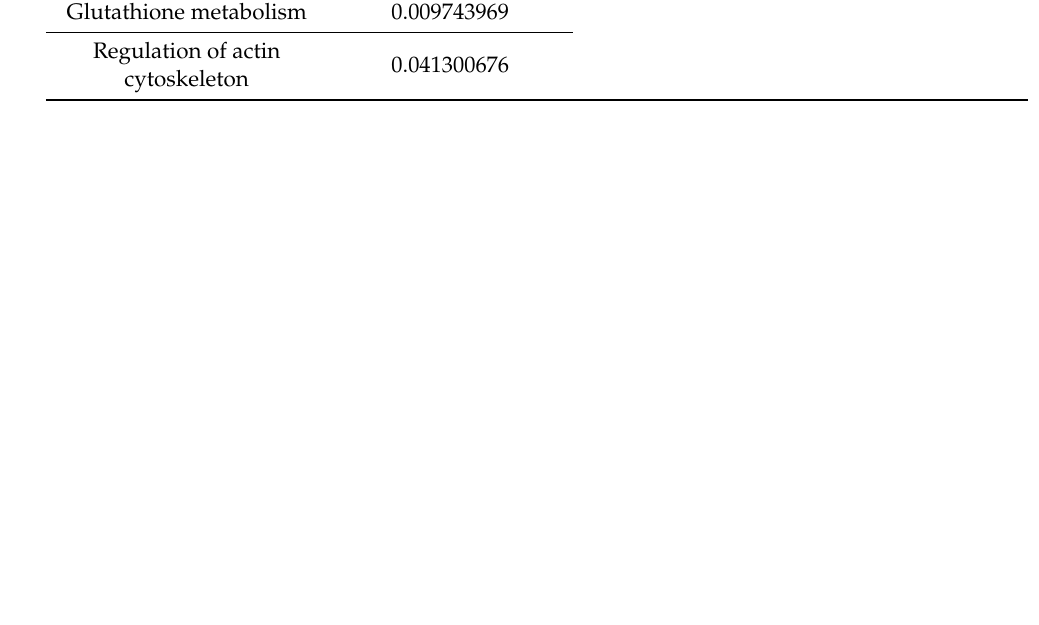
Figure 12. Upset plot of 10 GO terms.